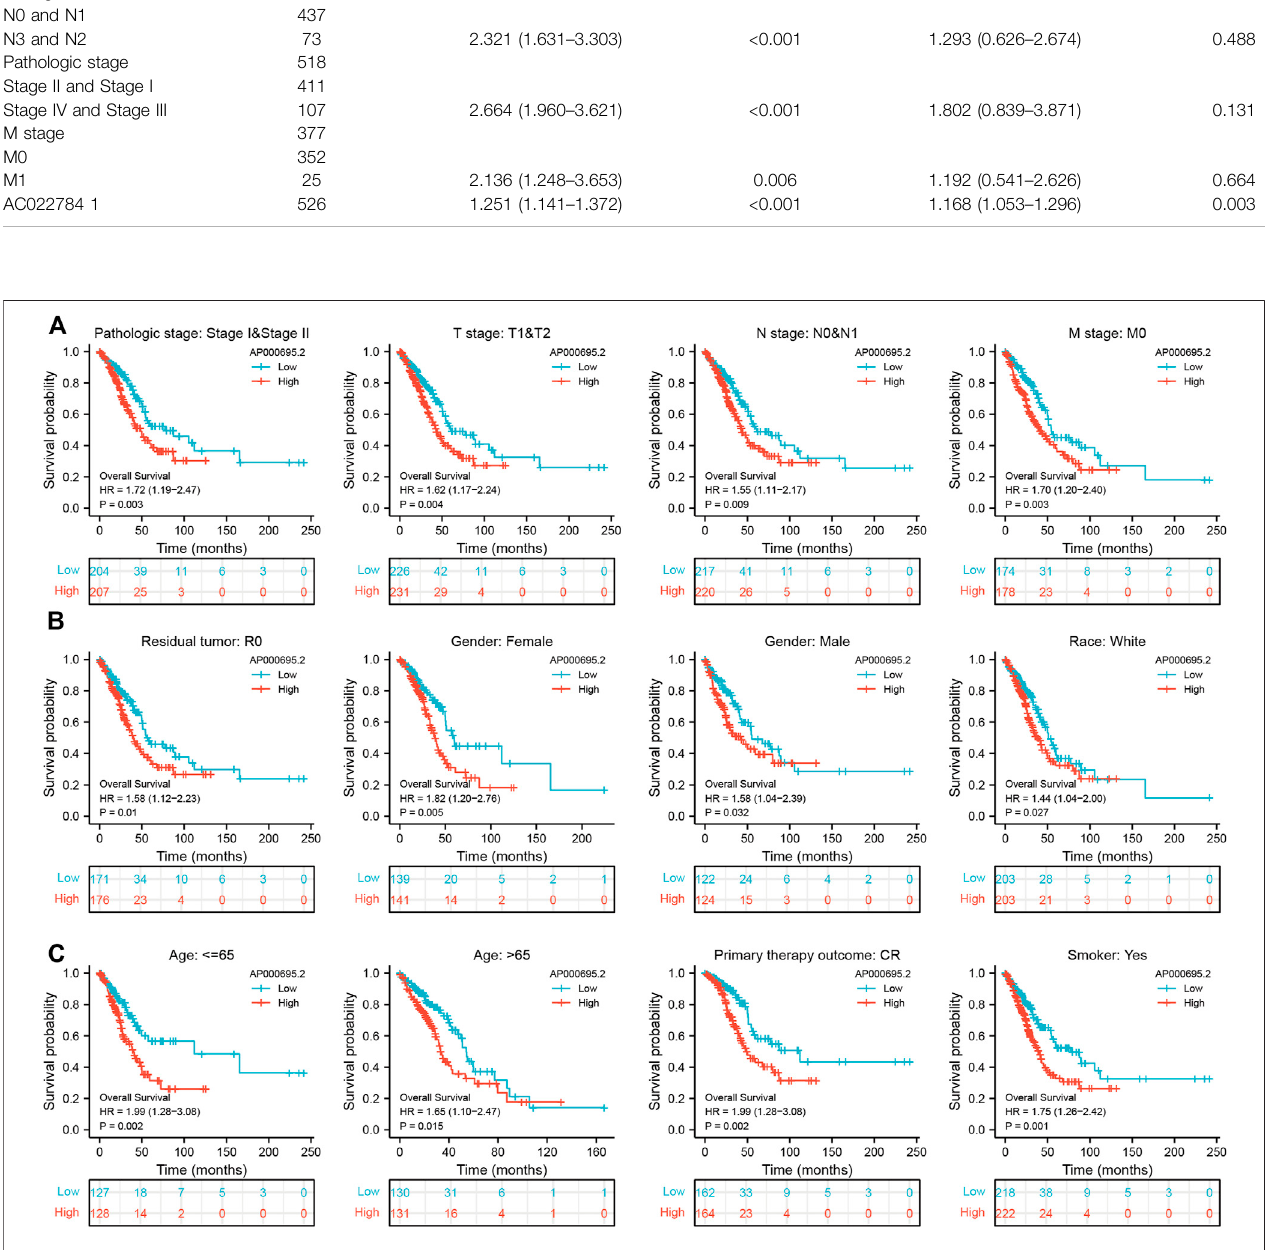
FIGURE3| Kaplan – MeiersurvivalanalysesforprognosticvaluesofAP000695.2indifferentsubgroupsstrati fi edbyclinicalfeatures. (A – C) Kaplan – Meiercurvesfor overall survival of AP000695.2 in subgroups including stages I-II, T1-T2, N0-N1, M0, R0, female, male, race, white, age > 65years, age < 65years, CR, and smoker in TCGA-LUAD